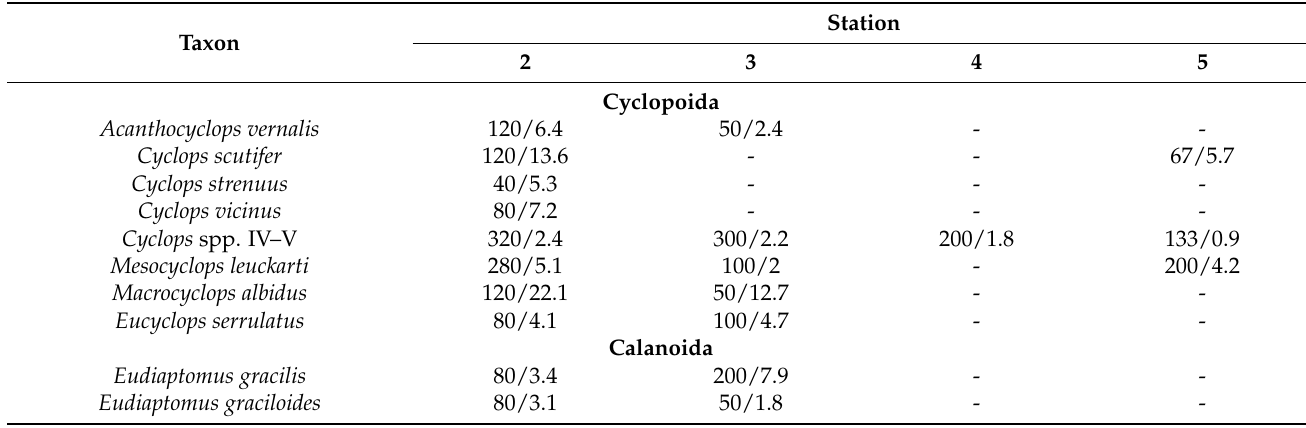
Table 2. The abundance (individuals m − 3 )/biomass (mg wet mass m − 3 ) of zooplankton taxa in Lake Kulonga in March